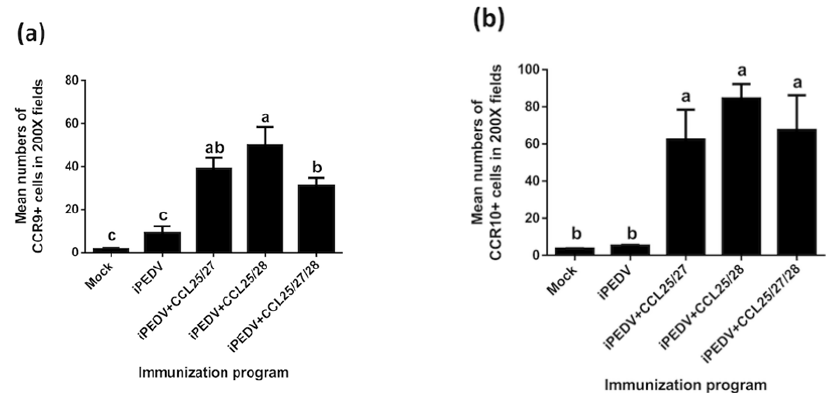
Figure 9. The average numbers of ( a ) CCR9 and ( b ) CCR10 positive cells were counted by a light microscopy over 10 different (200×) fields in each group at one week post the second immunization. Data are presented as the mean number ± standard deviation. Statistically significant differences are present among a, b, and c ( p < 0.05).